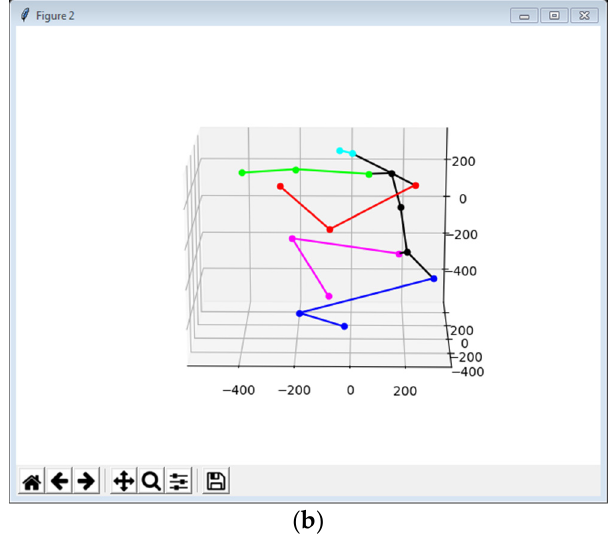
Figure 12. 3D key joints and skeleton extraction: ( a ) key joint distribution in the image frame of scaffolding erecting; ( b ) the corresponding skeleton model in 3D.